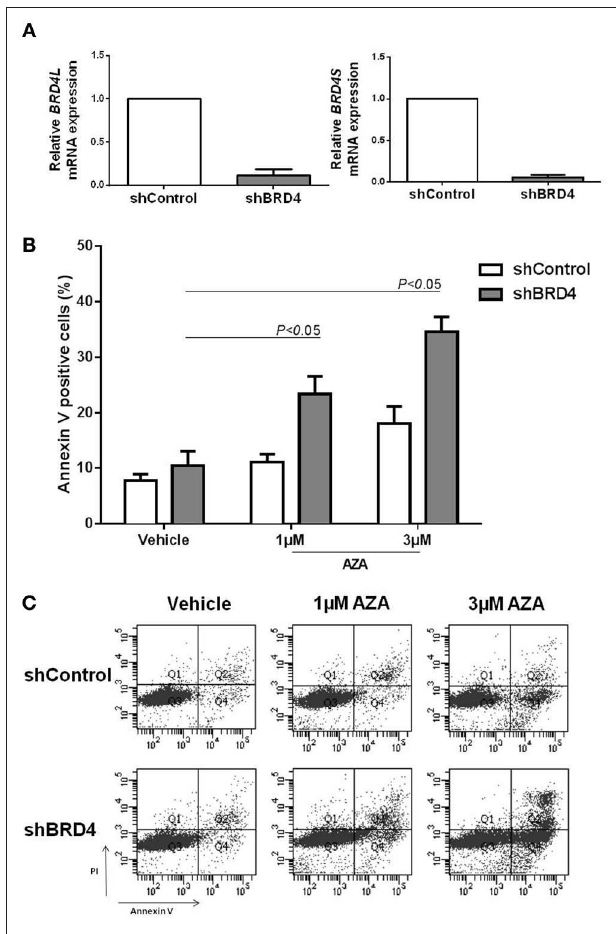
FIGURE 4 | BRD4 silencing increases apoptosis rate of U937 cells under azacitidine treatment. (A) Efficacy of BRD4 silencing in U937 cells transduced with lentivirus-mediated control (shControl) or BRD4 (shBRD4) measured by RT-PCR. (B) Silenced and control cells were treated for 48h with vehicle (DMSO) or azacitidine (1 or 3 µ M): and apoptosis was detected by flow cytometry. (C) Representative plot of increasing apoptosis of shBRD4 cells under AZA treatment. Significant P -values (one-way Anova test) are indicated in the graph. All bar graphs represent mean ± SD of at least four independent